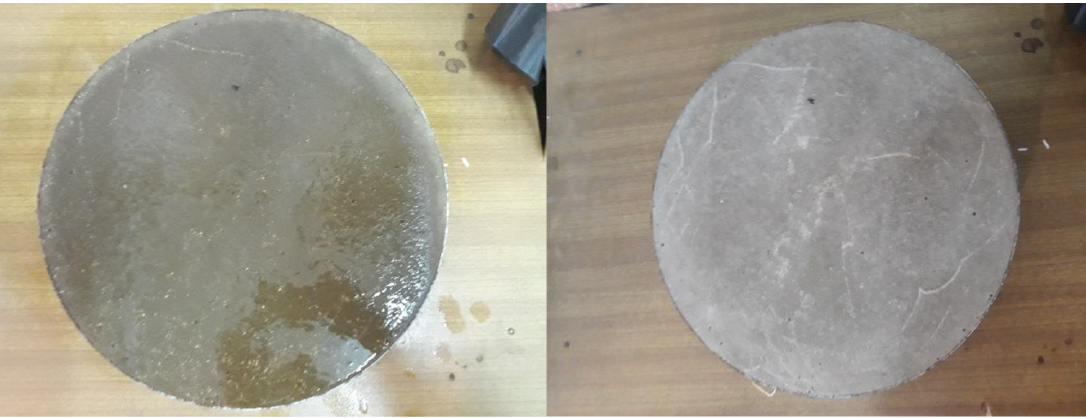
Figure 2 . Catalyst containing copper particles shortly after spraying ( left ) and after the drying process ( right ).